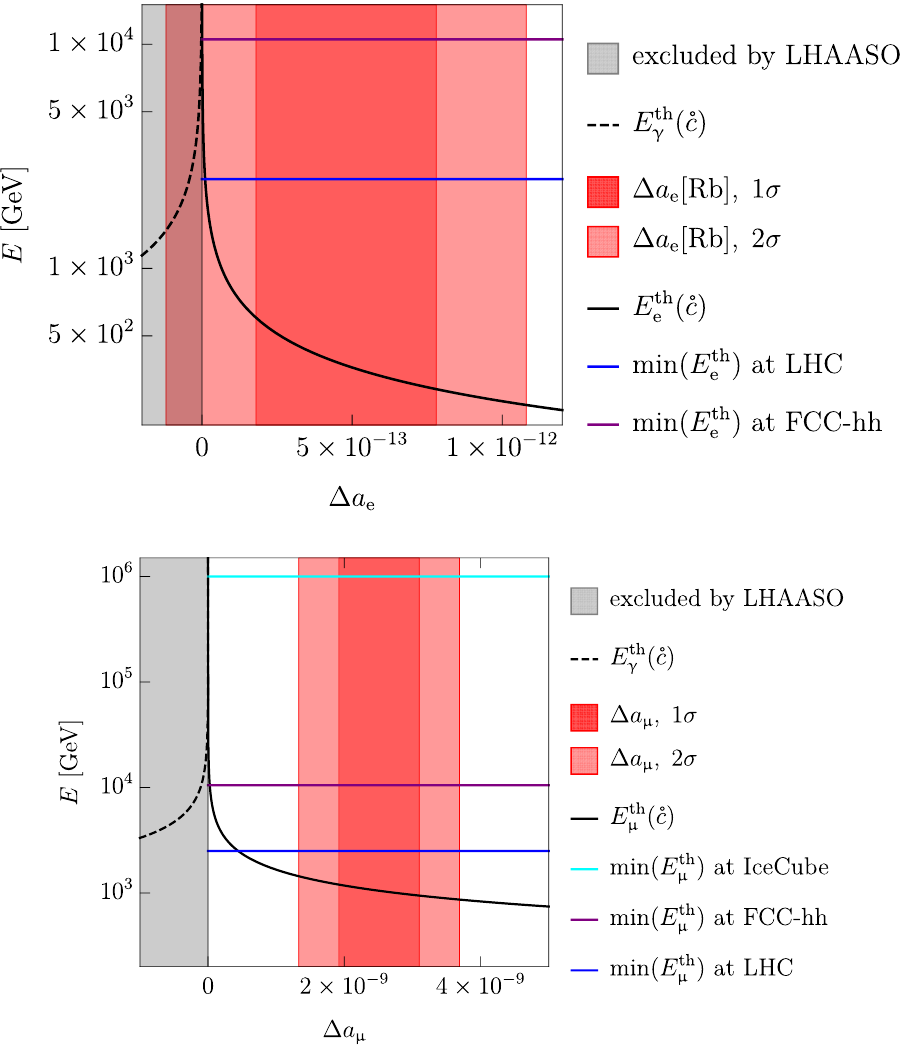
Figure 2 . Top (bottom): difference of the experimental average and the SM prediction of the anomalous magnetic moment of the electron (muon), ∆ a e ( ∆ a (cid:22) ), versus the charged-lepton energy. The threshold energy for photon decay, E th , in eq. (4.5) is illustrated by a dashed, black curve and (cid:13) the regions of ∆ a excluded by photon decay are coloured in grey. We do not show ∆ a e [Cs] , since e( (cid:22) ) the whole 2 σ -preferred region is excluded by LHAASO. The threshold energy for vacuum Čerenkov radiation, E th , given in eq. (4.1) is represented by a solid, black curve, whereas the lepton energies e( (cid:22) ) probed by IceCube, by the LHC, and by the proposed Future Circular Hadron Collider (FCC-hh) are indicated by horizontal lines. The regions to the right of the ∆ a -value corresponding to the inter- e( (cid:22) ) section of the curve E th ( E th ) with the LHC (IceCube) line are excluded. We observe that the Ice- (cid:22) e Cube measurements exclude the values of ˚ c ( (cid:22) ) that would be required to explain the tension in ∆ a (cid:22)